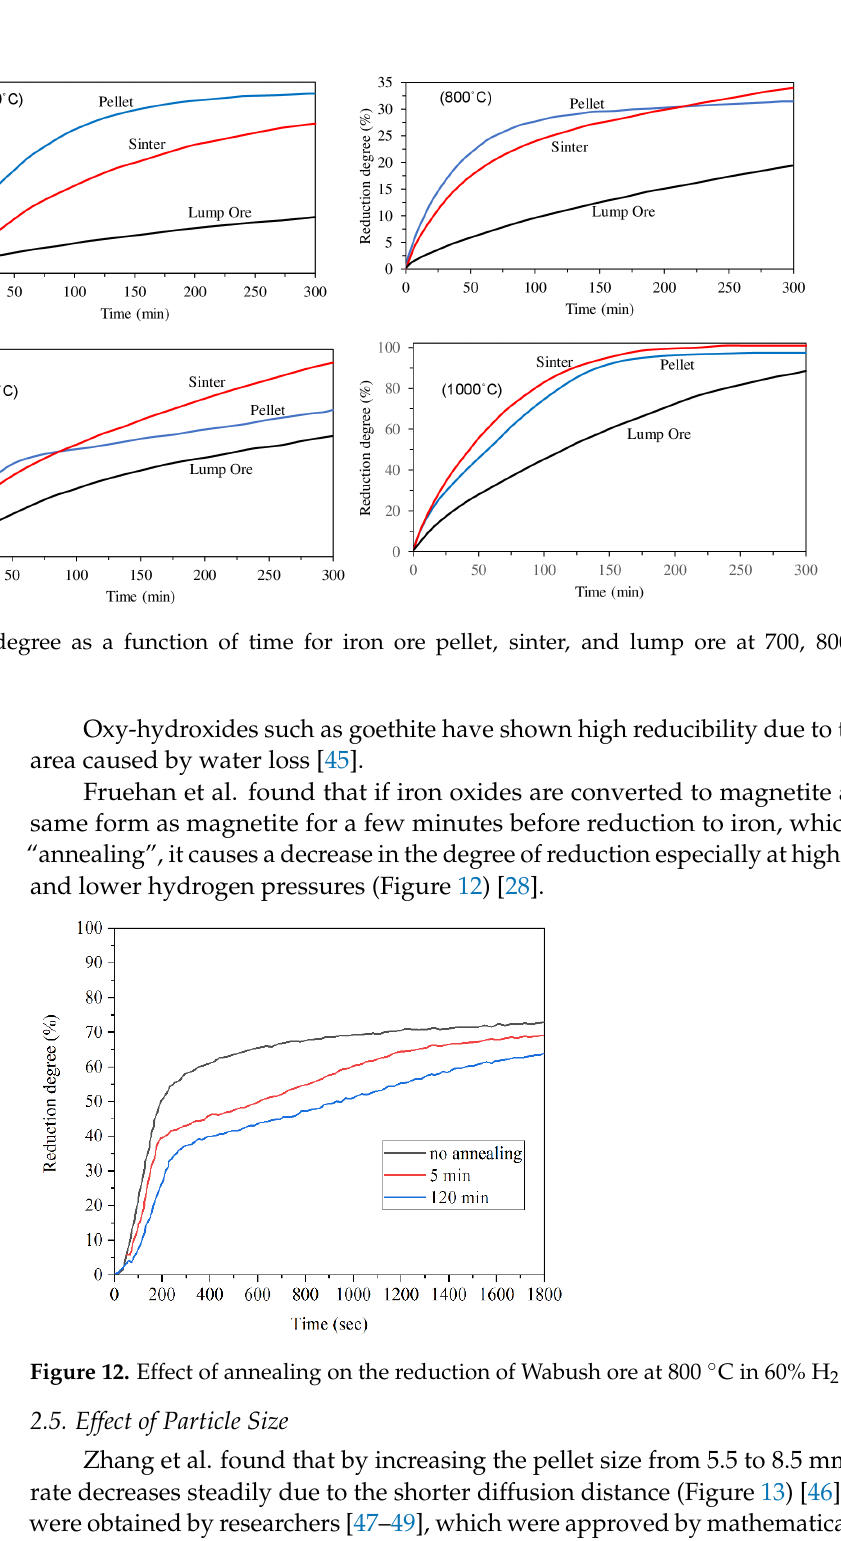
Figure 13. Dependence of reduction degree on reduction time of oxidized spherical pellets with different diameters. Data obtained at 1070 °C in flowing H 2 gas [46] “modified”. Wagner et al. investigated the hydrogen reduction of three samples of coarse powder (P1), sintered piece (S1), and nanopowder (N1). Although the specific area for N1 and S1 is higher than P1 due to their smaller particle size, the reduction of the P1 sample was faster than the two other samples. By investigation of the reduced samples’ morphology, it became clear that S1 and N1 samples became compact and lost most of their porosities after reduction while the P1 sample retains its porosity after the reduction (Figure 14) [26].